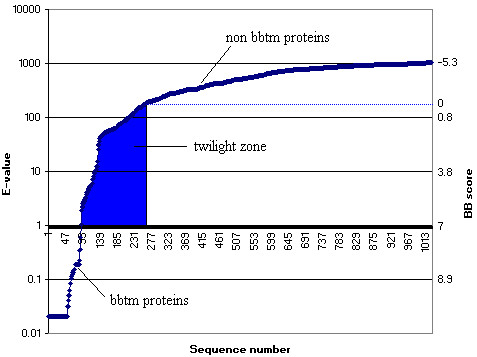
Range of E-values and BB-scores from E. coli screening. Sequences with a predicted signal peptide from the proteome of E. coli, were screened using the algorithm described. Sequences were then sorted by their E-values and plotted graphically. The graph demonstrates that in proteome screening with this tool there a number of sequences will be identified with positive bb scores, but E-values >1. Sequences with these scores are described as being in the twilight zone.